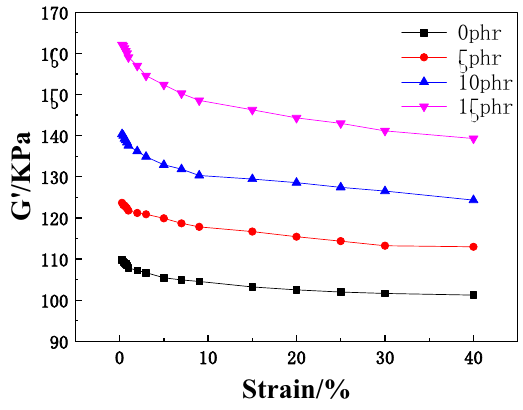
Figure 3: The e ff ect of di ff erent amounts of silica on Payne e ff ect of NH 4 Cl